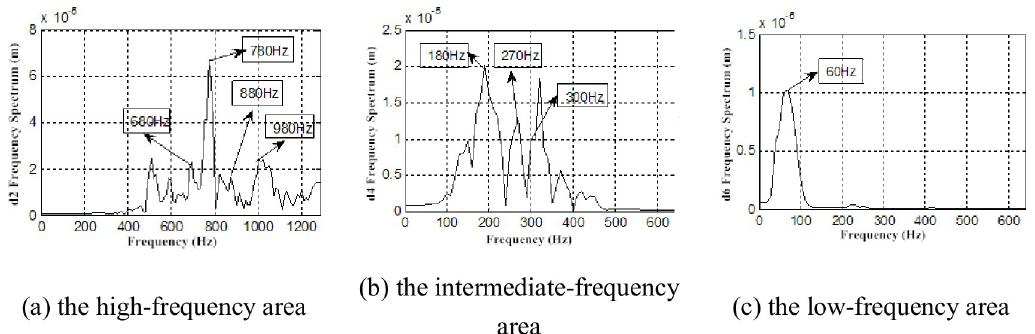
Fig 17. Frequency spectrum of Y direction displacement response restructuring signal under F =